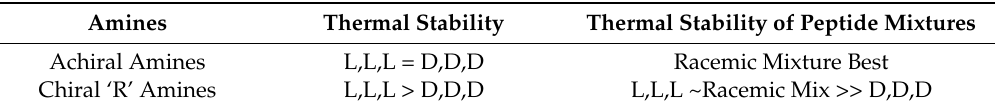
Table 6. Summary of main observations for the thermal stability of gels based on